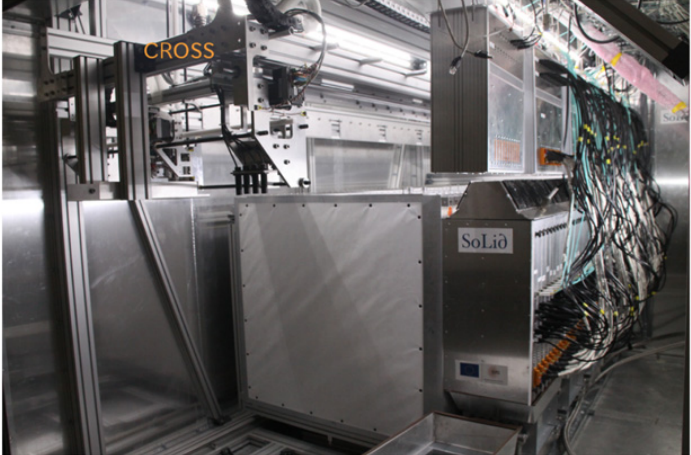
Figure 12. The detector, installed in the container. On the right, the module’s service box, electronics and heat exchanger. The automated calibration robot CROSS can lower calibration sources between any modules.